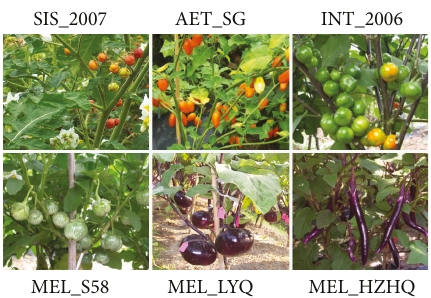
Figure 1: The fruit and leaf morphology of eggplant ( Solanum melongena ) and wild relatives. AET_SG: S. aethiopicum L.; SIS_2007: S. sisymbriifolium L.; INT_2006: S. integrifolium ; MEL_S58, MEL_HZHQ; MEL_LYQ: S. melongena